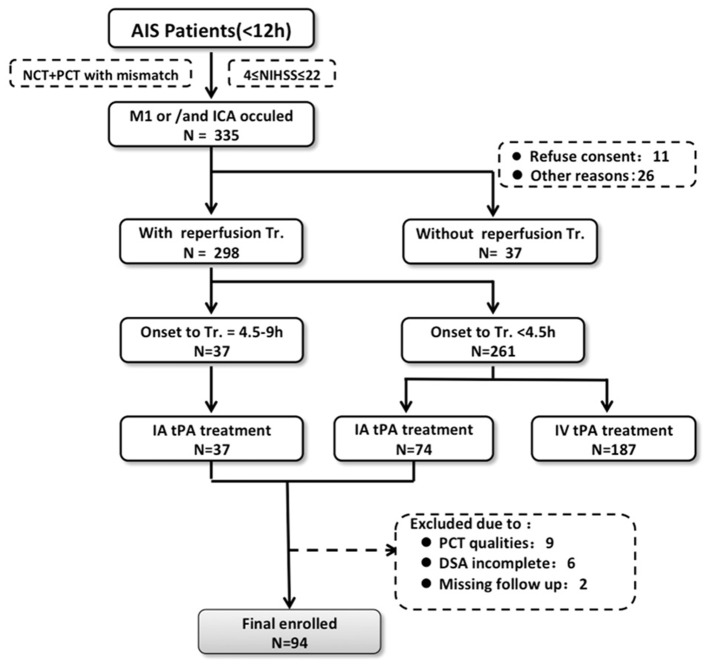
Flow chart outlining patient selection and exclusion criteria. AIS indicates acute ischemic stroke; DSA, digital subtraction angiography; IA, intra-arterial; IV tPA, intravenous tissue-type plasminogen activator; NCT, noncontrast-CT; NIHSS, National Institutes of Health Stroke Scale; CTP, computed tomography perfusion; and Tr, treatment.